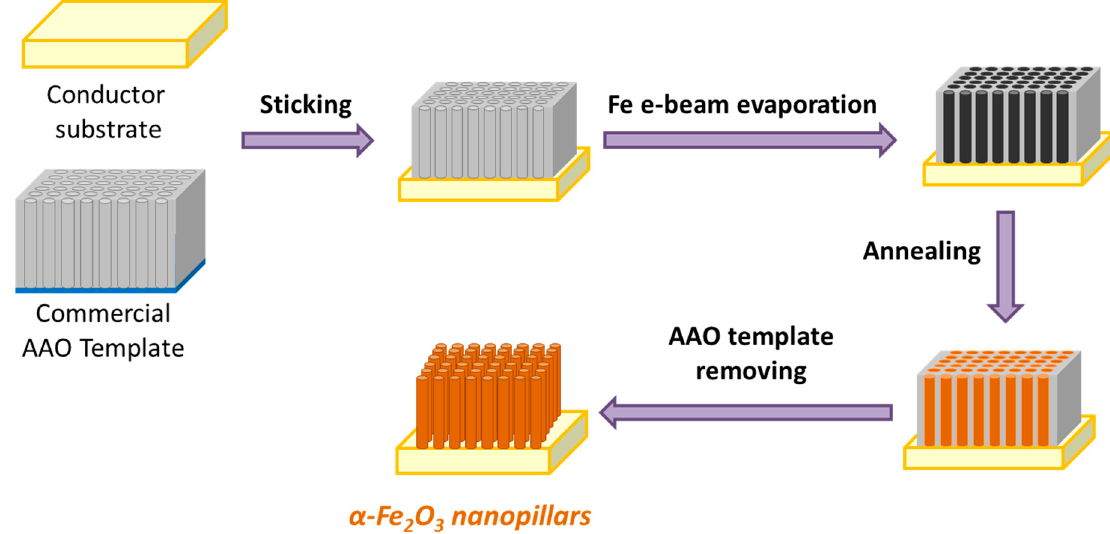
Figure 2. Schematic representation of the experimental procedure to fabricate self-standing α -Fe 2 O 3 nanopillars with controllable diameters, by using e-beam evaporation technique with AAO templates.